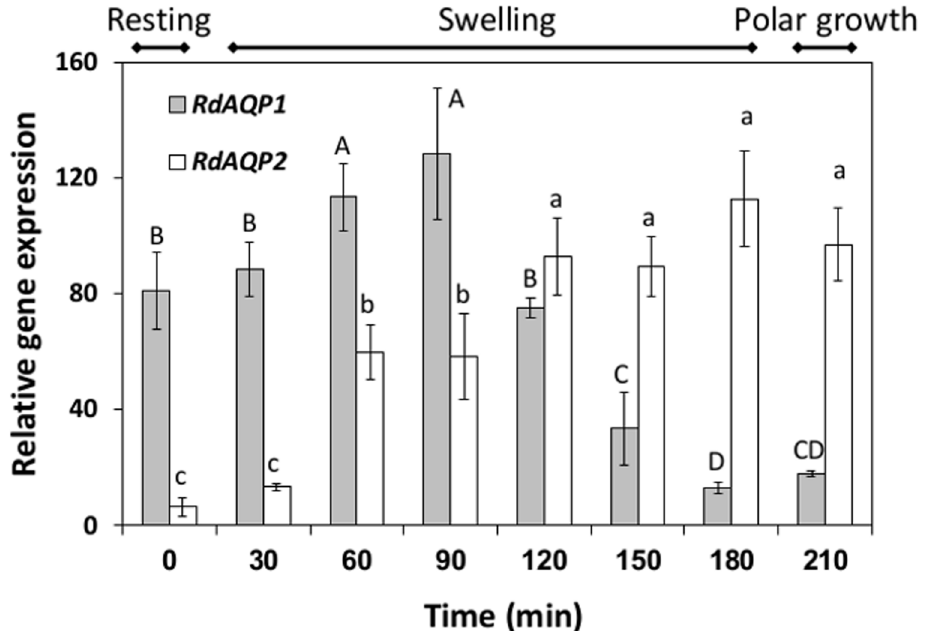
Fig 4. Differential expression of Rhizopus delemar putative aquaporin genes ( RdAQP1 and RdAQP2 ) during germination. R . delemar spores were incubated in SPAF and harvested at three main stages: resting (time 0), swelling (30 – 180 min) and polar growth (210 min). qPCR was performed on cDNA reverse-transcribed from the RNA extracted from the spores. Rhizopus 18S rRNA served as the reference gene. Values of the steady-state levels of gene transcripts were determined as the ratio between two conditions using the 2 Δ - Δ Ct method [50]. Values are means ± SE. Different upper or lowercase letters above the bars denote significant differences between measurement times in RdAQP1 or RdAQP2 respectively (P <